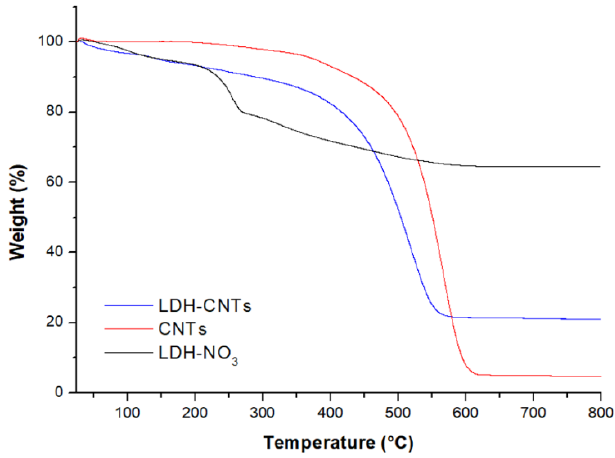
Figure 2. The TGA curves of LDH in nitrate form, the CNTs and the hybrid LDH-CNTs.